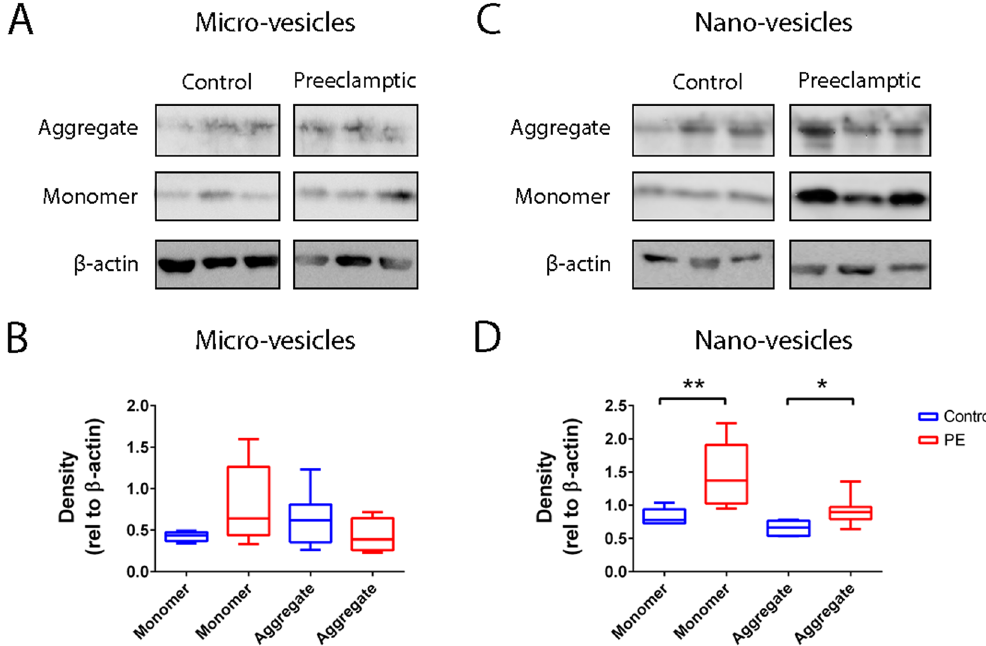
Figure 4. Transthyretin levels in micro- and nano- vesicles derived from normotensive and preeclamptic placentae. Western blotting of transthyretin in micro- ( A ) and nano- ( C ) vesicles from normotensive control and preeclamptic placentae was performed under non-reducing conditions. The levels of aggregated ( > 150 kDa) and monomeric (14 kDa) transthyretin were semi-quantitated relative to that of β -actin ( ** p = 0.0097, * p = 0.0176, n = 8, B , D ). Full-length blots are presented in Supplementary Figure 3. Data is plotted as box-whisker plots showing the median, interquartile range (box) and maximum/minimum